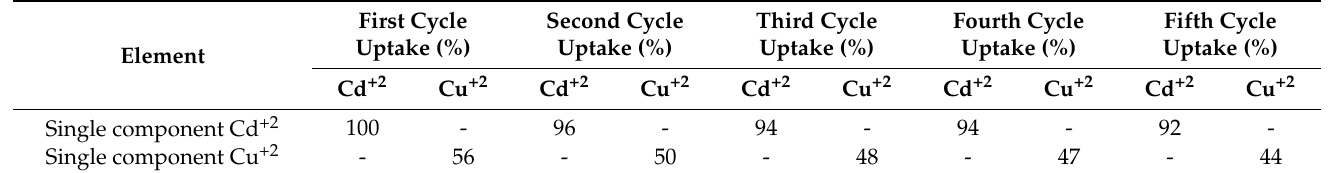
Table 4. Variation in the adsorption capacities of Cd +2 and Cu +2 with increasing numbers of regener- ation